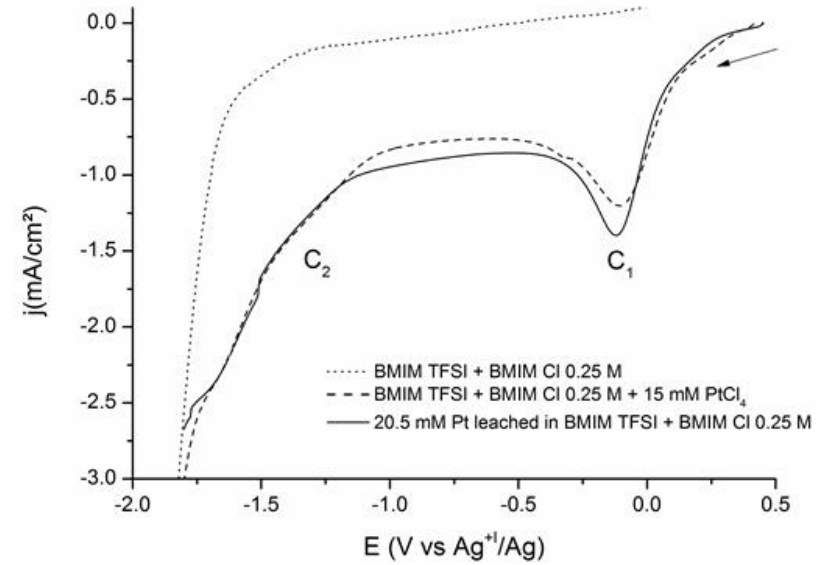
Figure 6. Linear sweep voltammetry performed on a glassy carbon electrode in IL melts under inert atmosphere, T° = 100 °C, sweep rate = 20 mV·s − 1 .